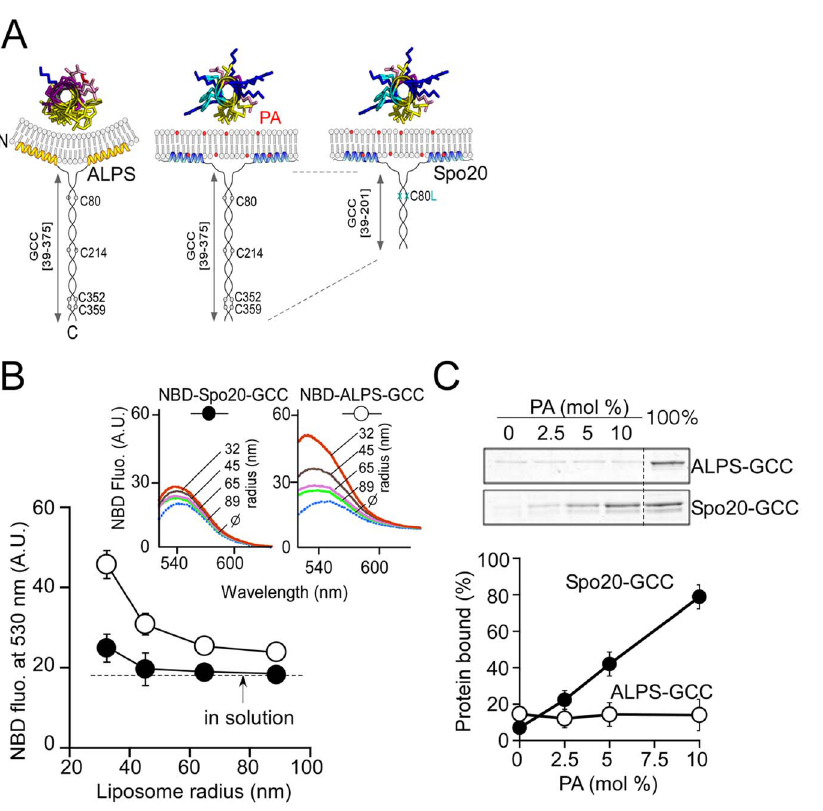
Figure 2. A bioprobe strategy to assess the membrane binding properties of the Spo20 sensor region. ( A ) Probe design. The probes were constructed according to the design of the N-terminal region of the Golgin GMAP-210. The ALPS motif of GMAP-210 was replaced by the Spo20 membrane region. In the case of the Spo20 probe, the coiled coil of GMAP was shortened by including a stop codon at position K202 and its endogeneous cysteines were mutagenized. The obtained construction, Spo20-GCC, is more soluble and was used for flotation and NBD-fluorescence experiments. ( B ) Membrane partitioning of the NBD labeled forms of Spo20-GCC or ALPS-GCC (0.3 m M) in the presence of liposomes of defined size as obtained by extrusion (0.35 mM lipids). The liposomes contained (mol %): PC (40), PE (30), cholesterol (25) and PA (5). ( C ) Flotation experiments. Spo20-GCC but not ALPS-GCC, bound to PA containing liposomes. Spo20-GCC or ALPS-GCC (0.75 m M) was incubated without liposomes or with liposomes (0.75 mM lipids) containing (mol %): PE (25), cholesterol (25), PS (15) and increasing amount of PA (0 to 15). The remaining lipid was PC. Liposomes were extruded through 0.2 m m filters.